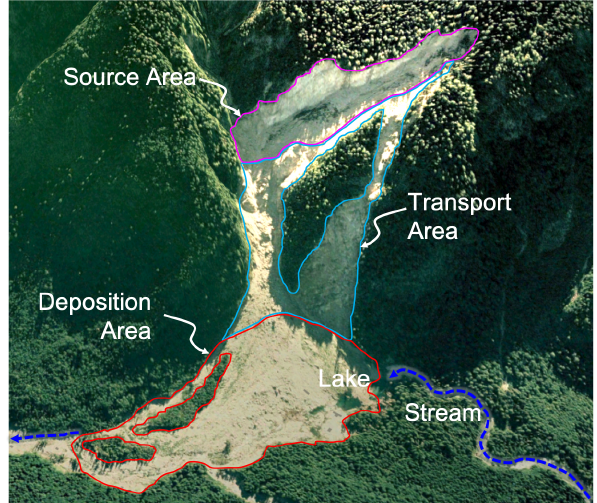
Figure 1. Primary landslide features of the Goodell Creek land- slide (October 2003) showing source, transport, and deposition areas illustrated over an aerial image. Base of the landslide is about 1km across. Location in the North Cascades National Park Complex is about 4km north of Newhalem, Washington. Source: © Google Earth, 48 ◦ 41 (cid:48) 55.72 (cid:48)(cid:48) N, 121 ◦ 17 (cid:48) 01.31 (cid:48)(cid:48) W, imagery data from 23 June 2006, viewed towards the